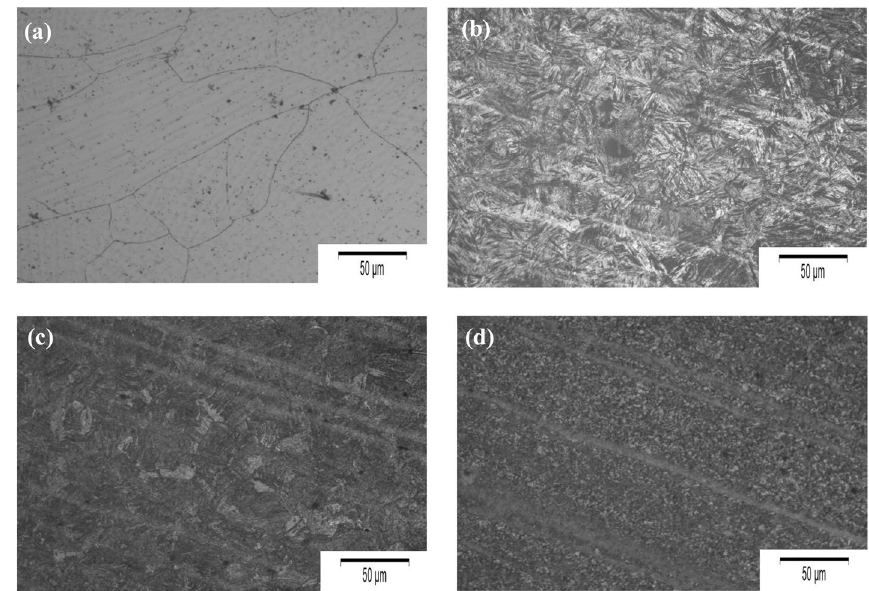
Fig. 23 Microstructure of single bevel welded joint using AWS A 5.9 ER 307 filler metal a Weld metal. b Martensite structure in weld metal zone. c Grain coarsening zone containing a martensitic structure in HAZ zone. d Over-tempering (softening zone) in HAZ